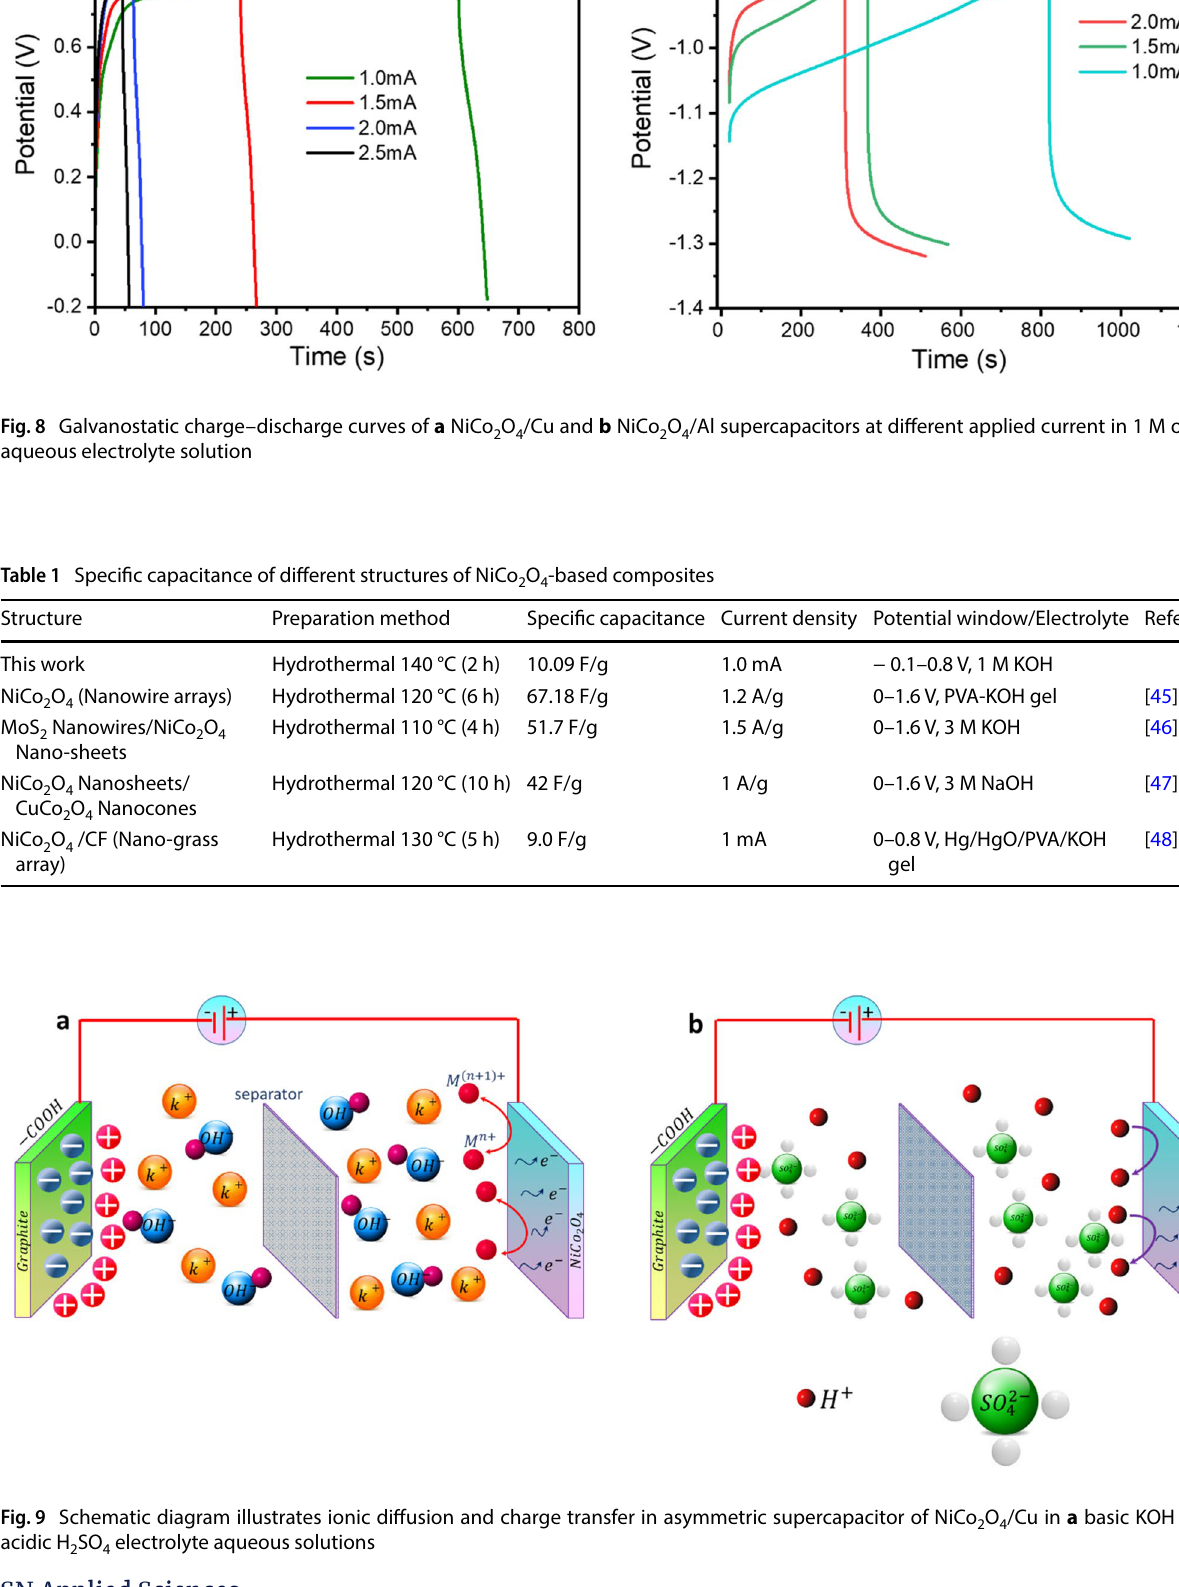
O /Cu in a basic KOH and b 2 4